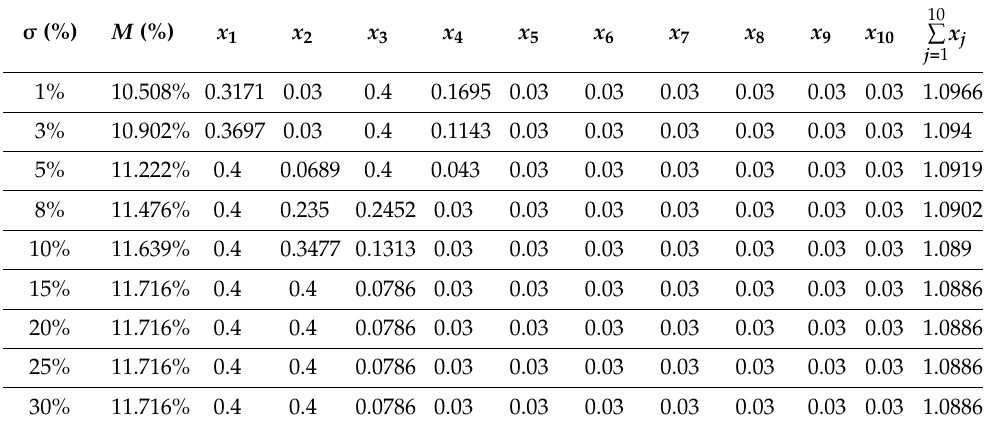
Table 9. The possibilistic efficient portfolios with b = 0.25, p 1 = 0.3, p 2 = 0.2, p 3 = 0.2.